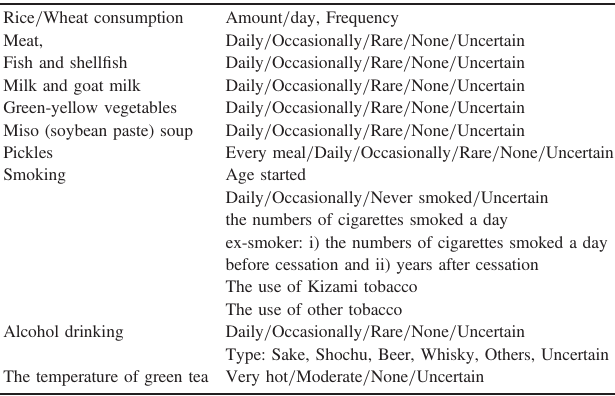
Table 1 summarizes questions related to lifestyles included in the questionnaire.